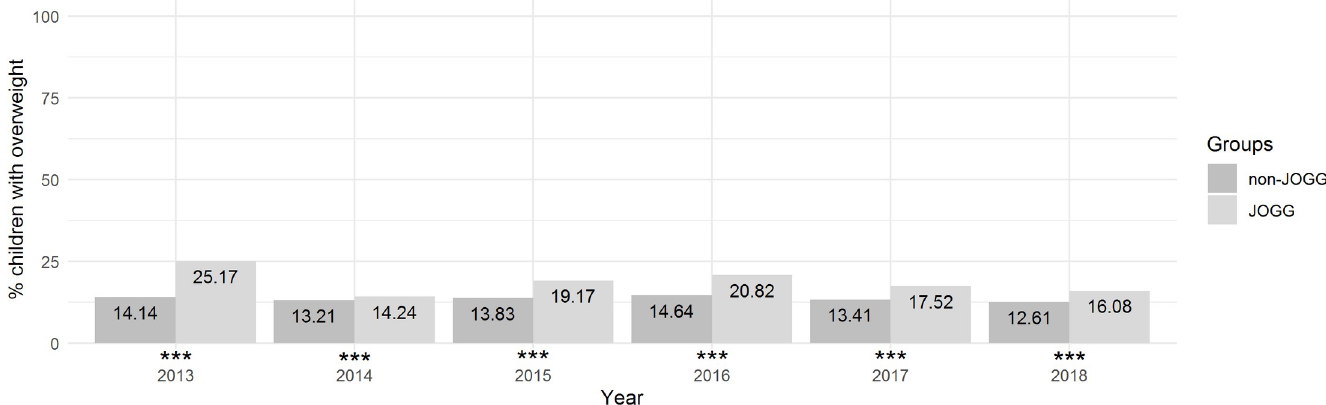
Fig 2. Prevalence of overweight in JOGG areas and non-JOGG areas. Visual representation of overweight prevalence among children in non-JOGG areas and JOGG areas between 2013 and 2018. � p < .05; �� p < .01; ��� p < .001.